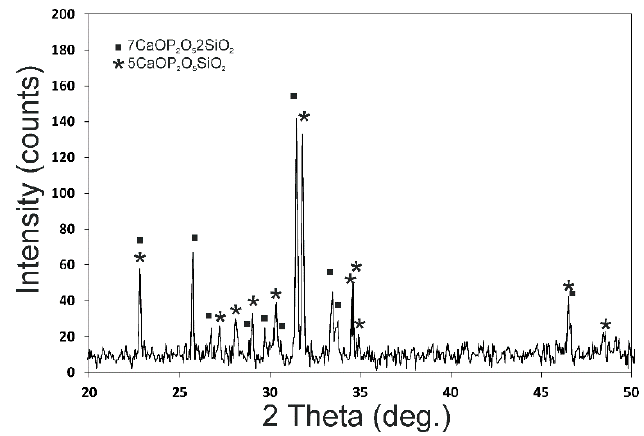
Figure 5. X-ray diffraction pattern of the synthesized CSP scaffold.